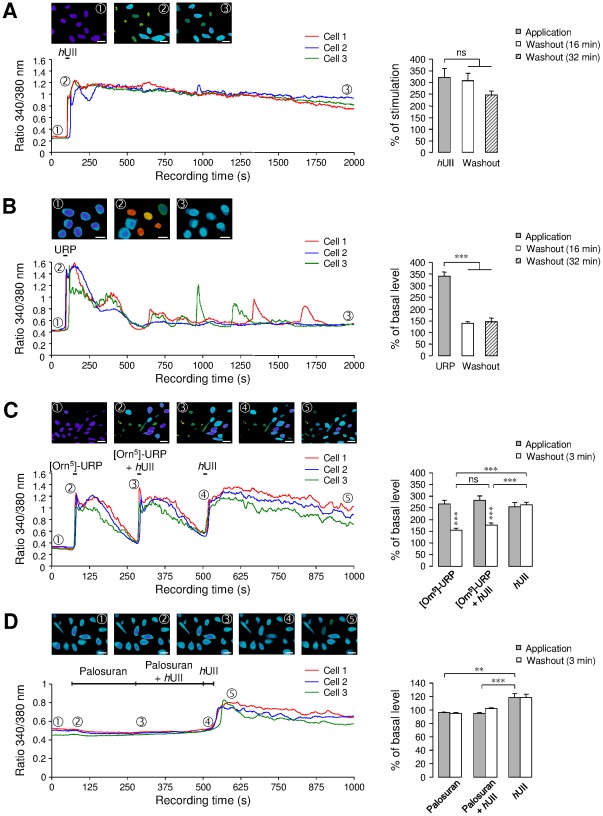
Role of specific UT ligands on cytosolic calcium in CHO-UT.(A, B) hUII (A) or URP (B) (10−8 M, each) provoked a robust increase of [Ca2+]c, which remained stable (A) or recovered to the basal line level (B) during washout. (C, D) Effect of the UT antagonists [Orn5]-URP (10−6 M, C) or palosuran (10−6 M, D), before and during hUII application. Right, bar graphs represent the percent increase of the [Ca2+]c during drug perfusion or during the washout period. Percent values were obtained by normalizing signals evoked during and after treatments to the value measured before ligand application. Data are mean ± SEM from 9 to 25 cells. ns, non significant; ** P<0.01; *** P<0.001 compared with the corresponding control Iso-evoked current. In each type of experiment, three different cells have been selected as representative exemples.